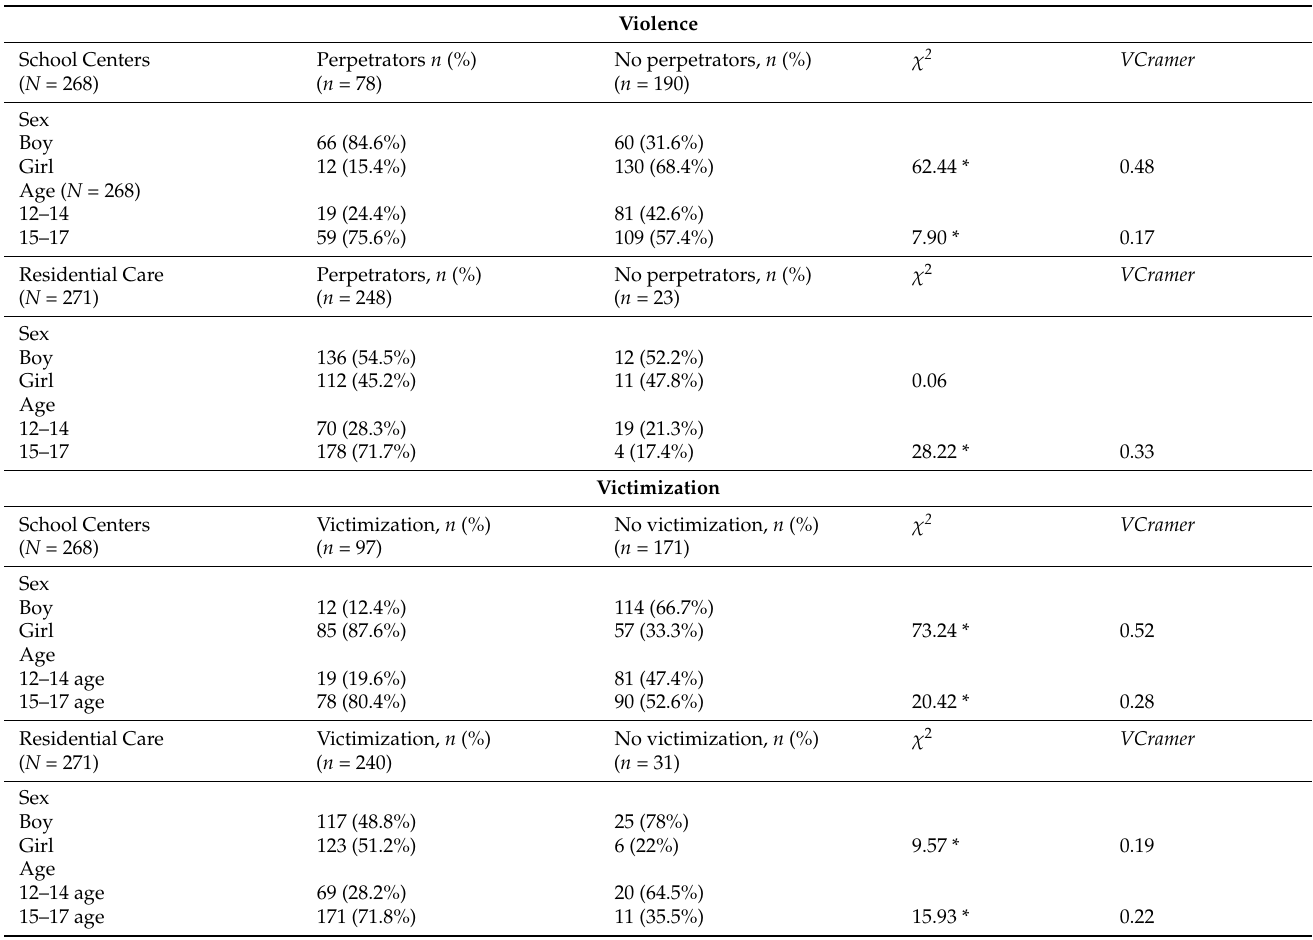
Table 1. Prevalence of violence as a function of sex and age in both study